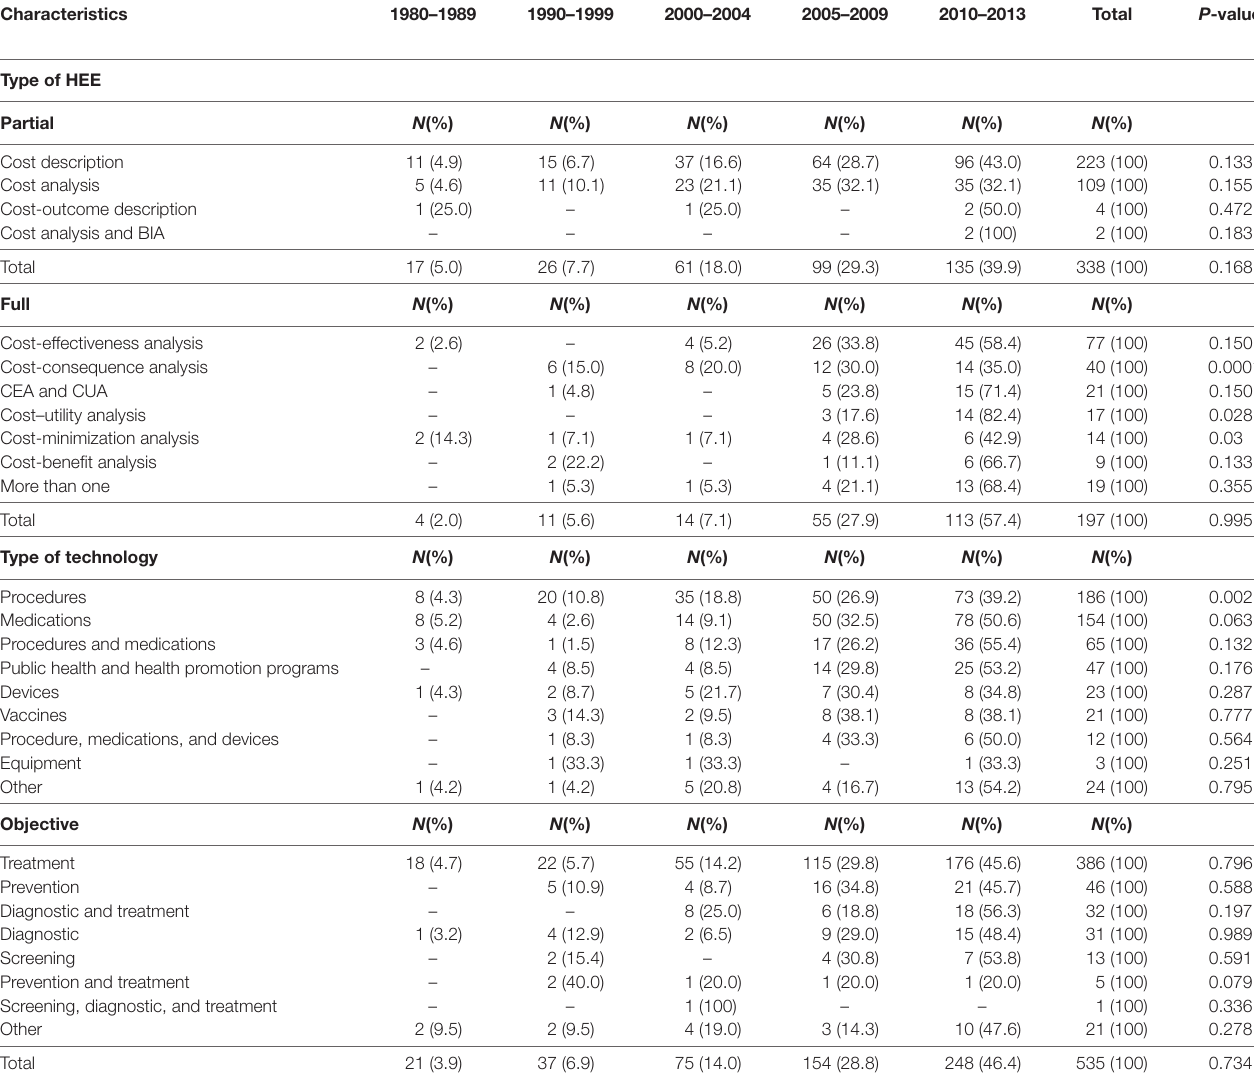
taBLe 2 | Characteristics of health economic evaluation (HEE), according time period, Brazil,